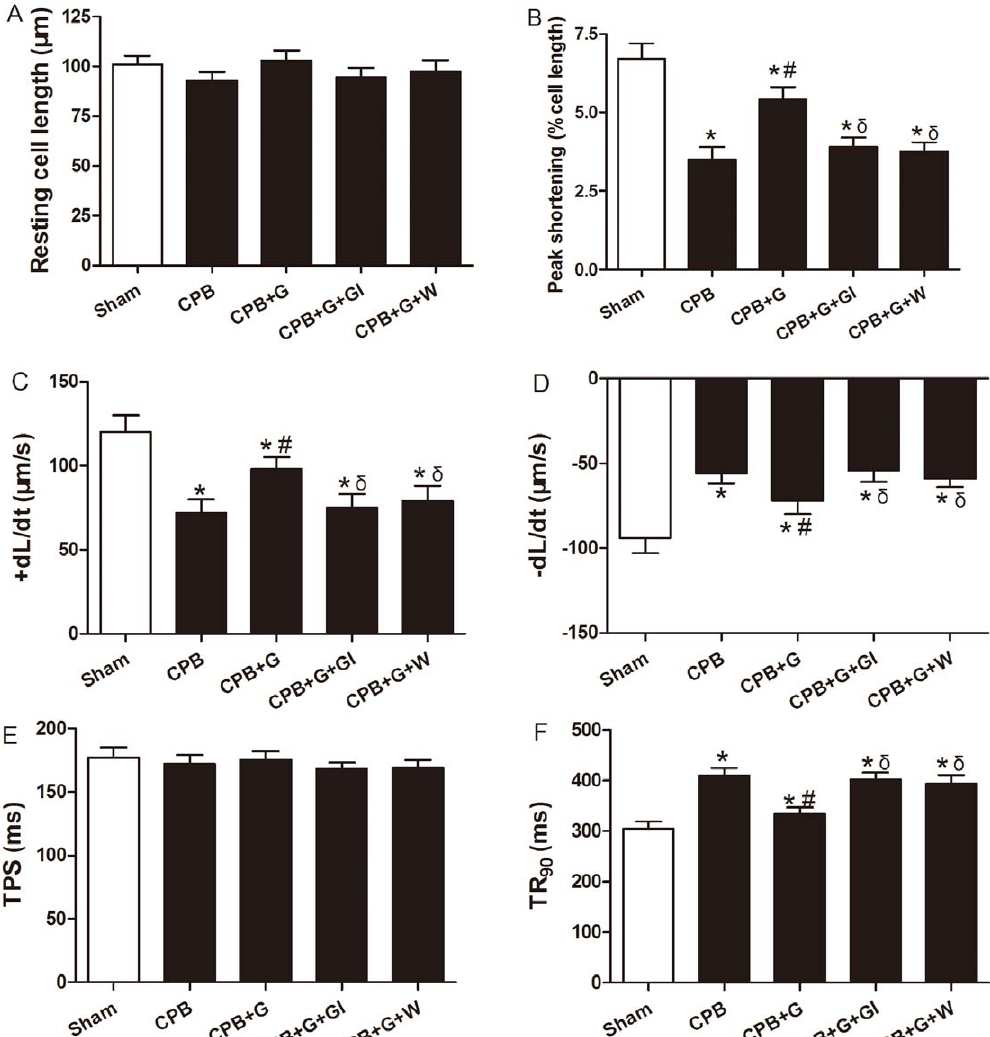
Figure 3. Cardiomyocyte contractile properties following CPB. (A) Resting cell length; (B) peak shortening (PS, normalized to cell length); (C) maximal velocity of shortening ( + dL/dt); (D) maximal velocity of relaxtion (-dL/dt); (E) time-to-PS (TPS) and (F) time-to-90% relaxtion (TR90). Values presented are mean 6 SEM, n=68–74 cells for each group from four rats per group. G, ghrelin; GI, [D-Lys3]-GHRP-6, ghrelin inhibitor; W, wortmannin, a PI3K inhibitor. * P , 0.05 vs. Sham, # P , 0.05 vs. CPB, d P , 0.05 vs. CPB +